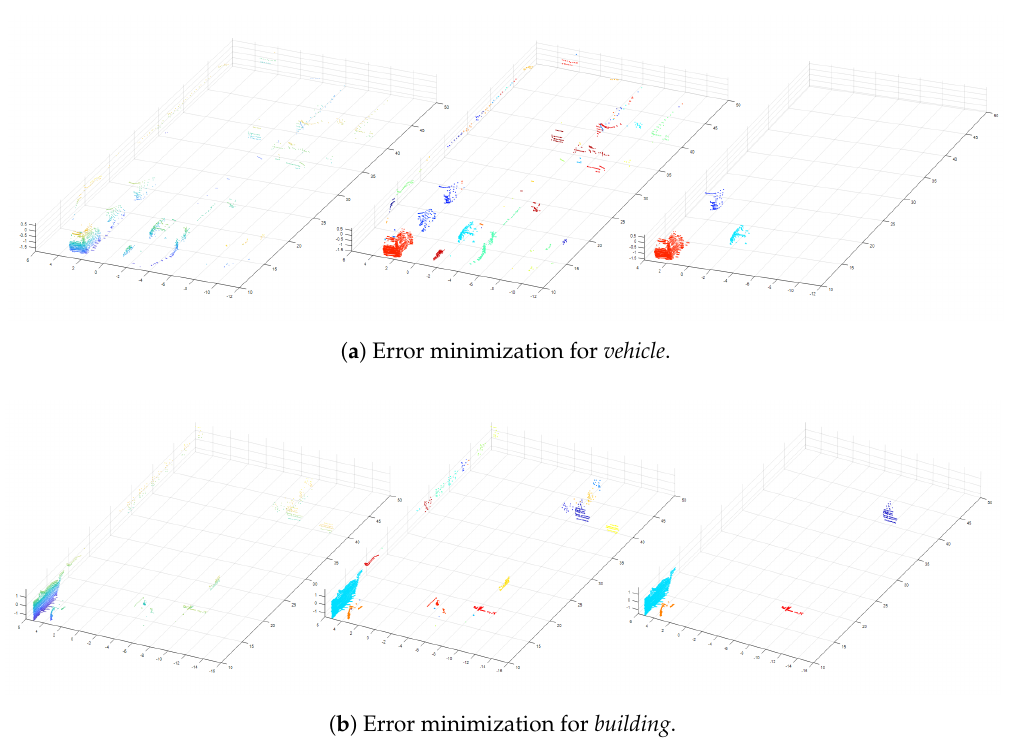
Figure 5. Result of the error minimization process. (First column) a set of voxels with the same label. (Second column) results of Euclidean clustering. (Third column) results obtained by the